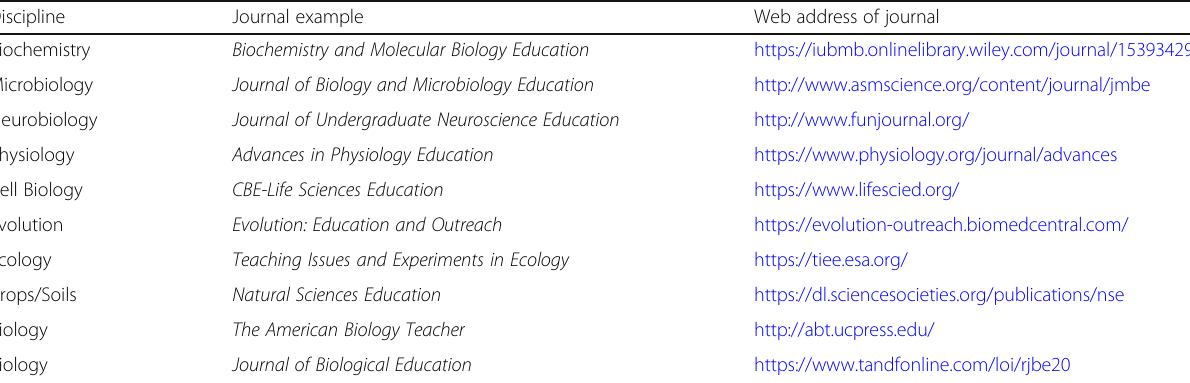
Table 1 Examples of Biology Education Research (BER) journals aligned with particular disciplines or targeted to particular groups of biological specialists. Note that CBE-Life Sciences Education has evolved to encompass a much broader audience of